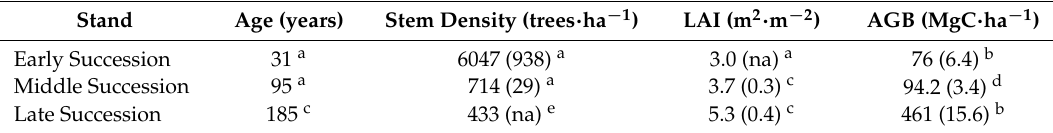
Table 1. Stand characteristics. All values are means (standard error) for each study site.